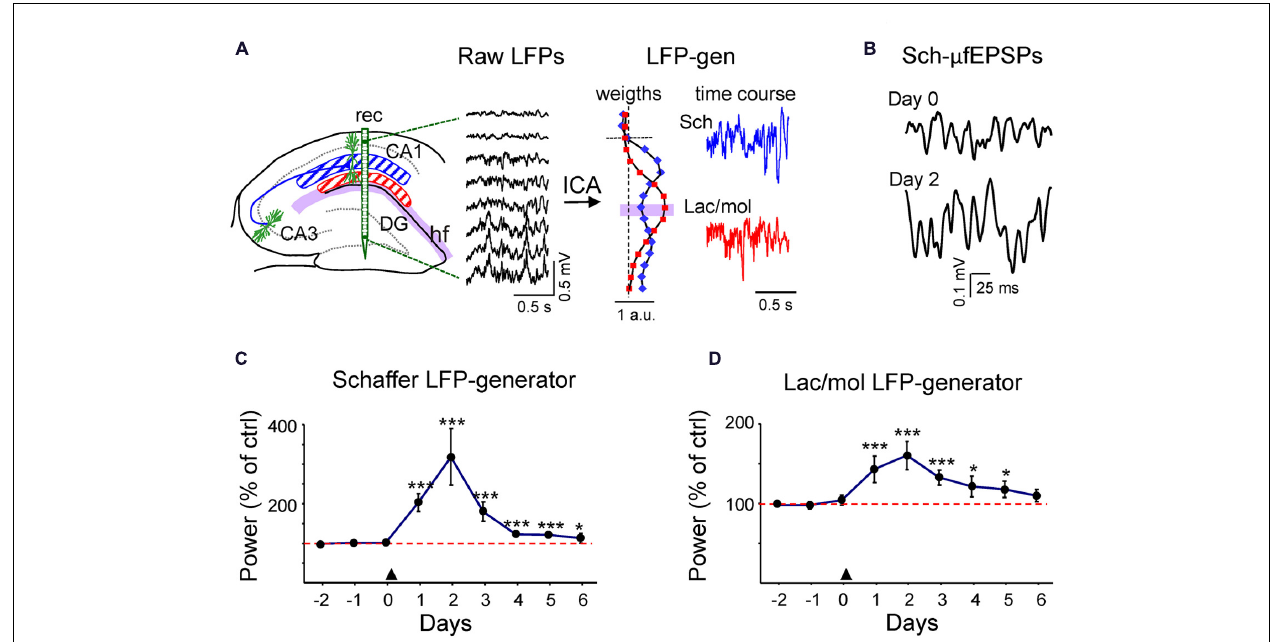
LFP activity was recorded during the three days prior to PTD4-PI3KAc injection (marked by an arrowhead at day zero) and for 6 days afterwards.The power of an LFP generator estimates the magnitude of the ongoing synaptic input from a specific afferent pathway to the target population (CA1 pyramids). It was calculated in 200-s epochs and plotted for each day as a percentage of the mean power of the control (red dashed line), estimated as the average of the 3 days before injection). Both the Schaffer (C) and the lac.-mol. (D) LFP generators exhibited a strong power increment that peaked 48 h after the treatment and decayed over the following days (Student’s t -test). Sample traces of reconstructed virtual LFPs at Day 0 (control) and two days post-injection are shown in (B)